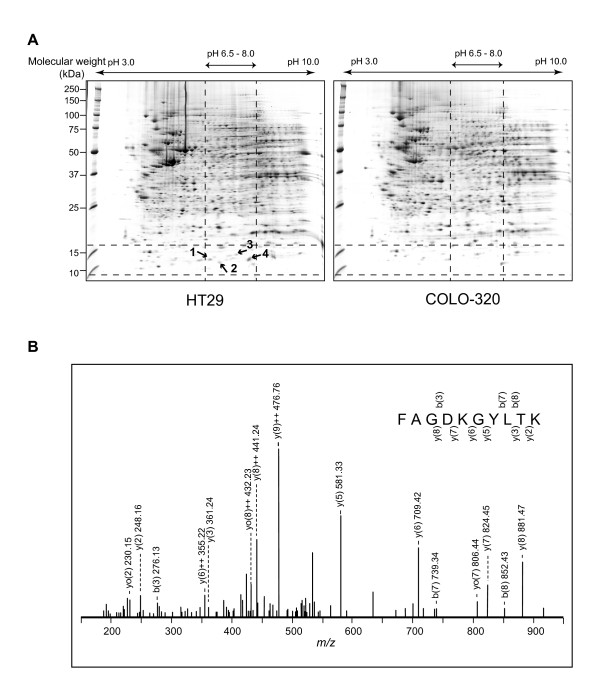
Identification of the 11.1 kDa protein. (A) 2-DE maps of whole cell lysates from HT29 (left panel) and COLO-320 (right panel), which showed high and low expression of the 11.1 kDa protein, respectively. The 4 spots indicated by the arrows were selected on the basis of the experimental molecular mass (m/z 11,072) and experimental pI (7.0-7.5) of the candidate protein. (B) The MS/MS spectrum of tryptic-digested m/z 550.29 recorded from spot 4. The amino acid sequence of this peptide fragment is highlighted on the spectrum.